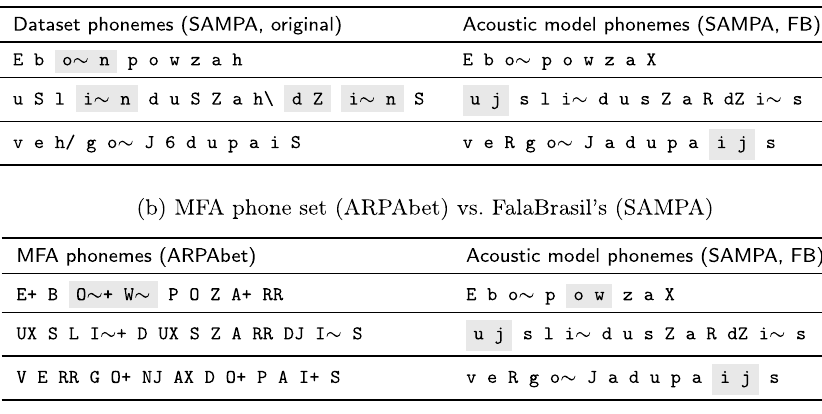
Table 8 Conversion of time stamps for the sentence “ onde existem ”